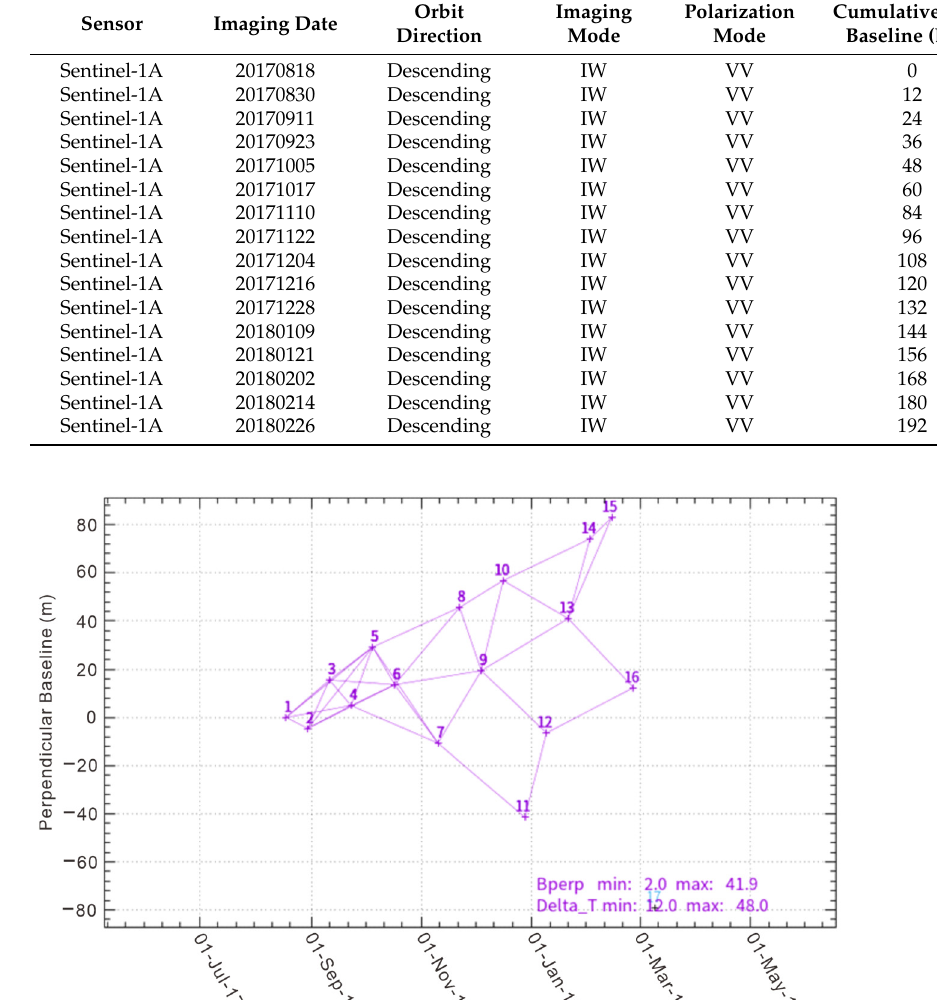
Figure 3. Interferometric image space–time baseline map .